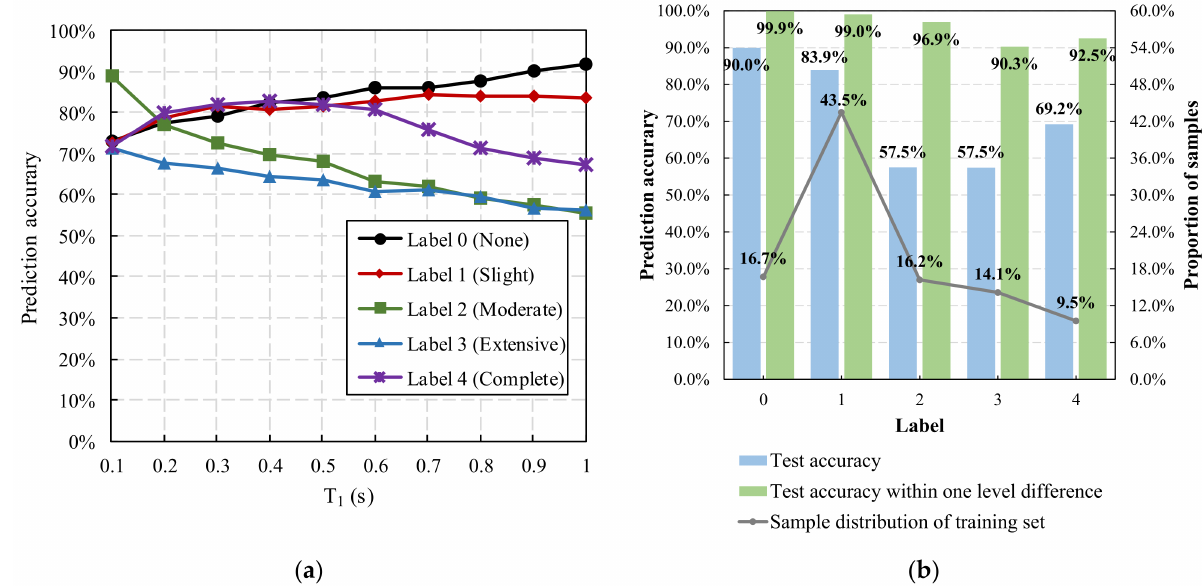
Figure 11. Influence of T 1 on prediction accuracy: ( a ) prediction accuracies for samples with different fundamental periods; ( b ) distribution and prediction accuracy for samples with T 1 of 0.8–1.0